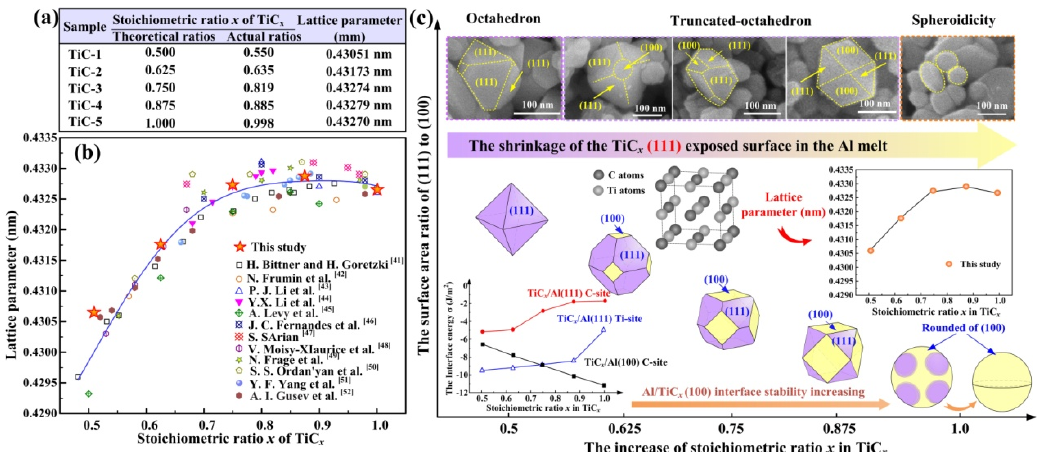
Figure 12. ( a ) The theoretical and actual stoichiometric ratios and the corresponding extracted TiC x lattice parameters; ( b ) The lattice parameters and corresponding estimated stoichiometric ratios of TiC x in this case compared with previously reported experimentally determined data; ( c ) The TiC x nanoparticles morphology evolution manipulating mechanism by the stoichiometric ratios in the Al melt. With permission from Reference [101], copyright (2019) Elsevier.